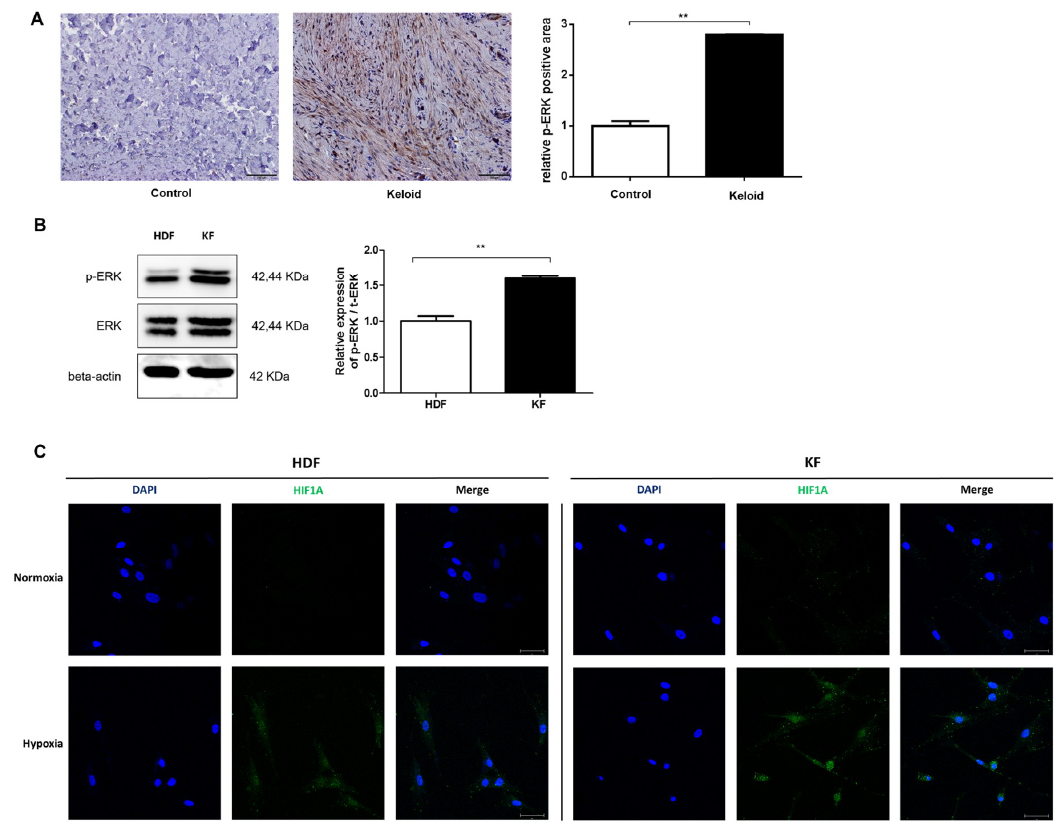
Figure 1. Phosphorylated extracellular signal-regulated kinase (p-ERK) levels in keloid tissue and fibroblasts. (A) Immunohistochemical analysis showed that the appearance of p-ERK was higher in keloid tissue than in adjacent normal tissue. Semi-quantitative analysis using Metamorph image analysis software revealed that the p-ERK levels were increased by 2.8-fold in keloid tissue compared with normal tissue. 100× magnification, scale bar = 200 μm. ** p < 0.01. (B) Western blot analysis showed that patient-derived keloid fibroblasts (KFs) had higher levels of p -ERK than human dermal fibroblasts (HDFs). ** p < 0.01. (C) Hypoxia-inducible factor-1α (HIF-1α) nuclear translocation in KFs was increased after exposure to 12 h of hypoxia; DAPI (blue), HIF-1 α (green), scale bar = 50 µ